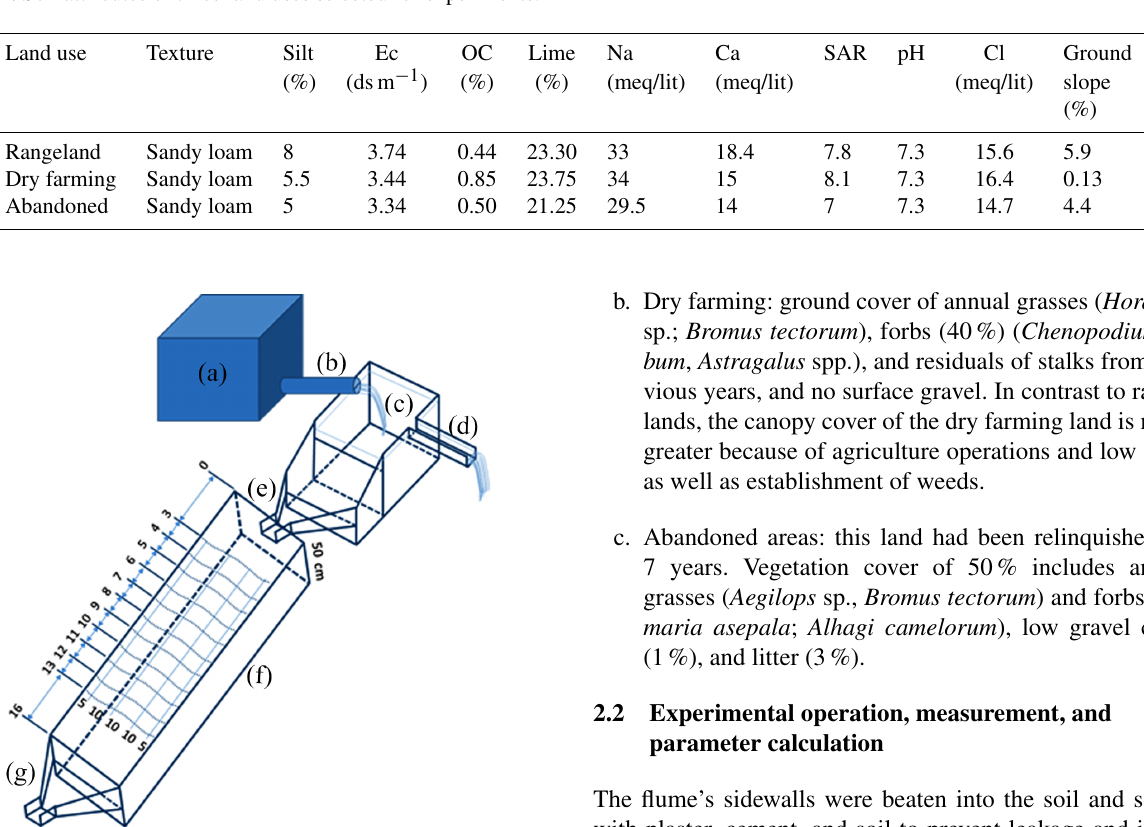
Table 1. Soil attributes of three land uses selected for experiments.